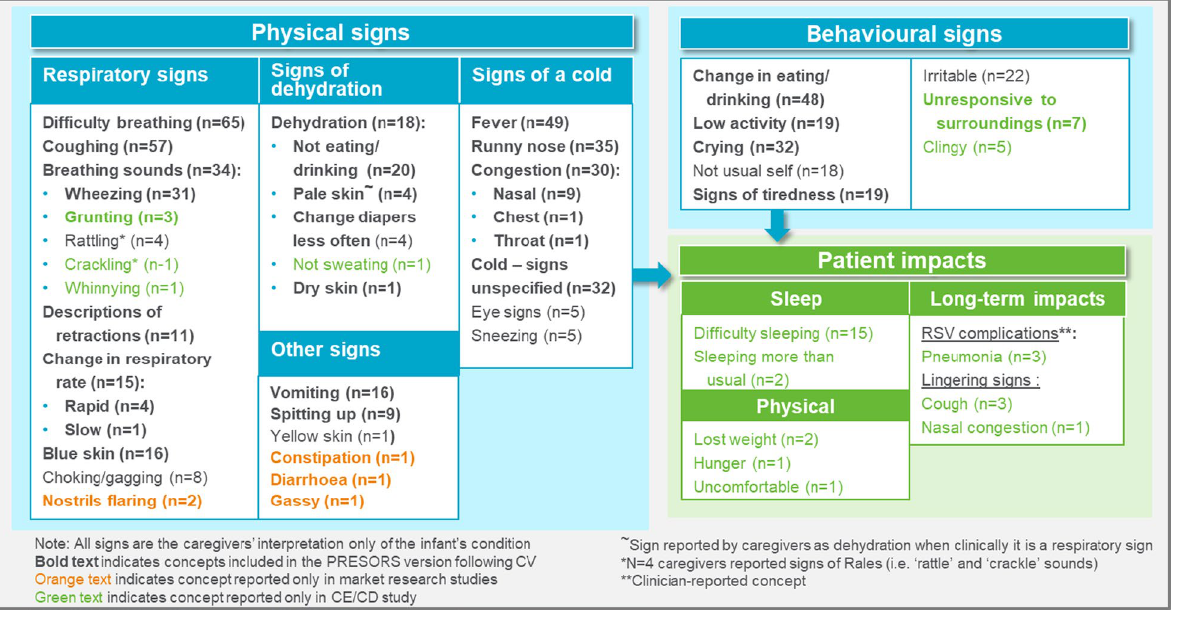
21) and patient journey (n 50) interviews = =